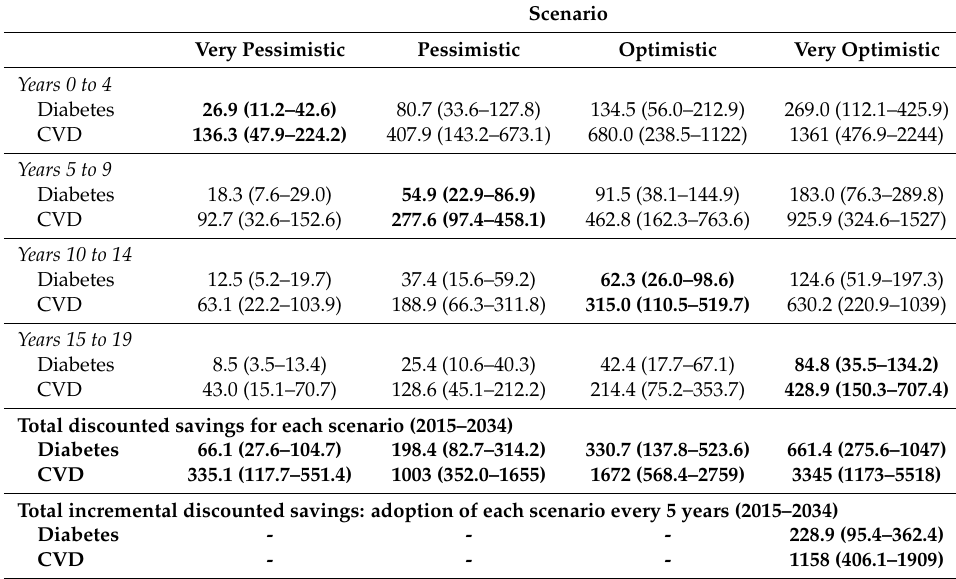
Table 9. Sum of potential total discounted savings on healthcare and related costs of type 2 diabetes and cardiovascular disease among Canadian adults from low glycemic and/or high fiber diets that